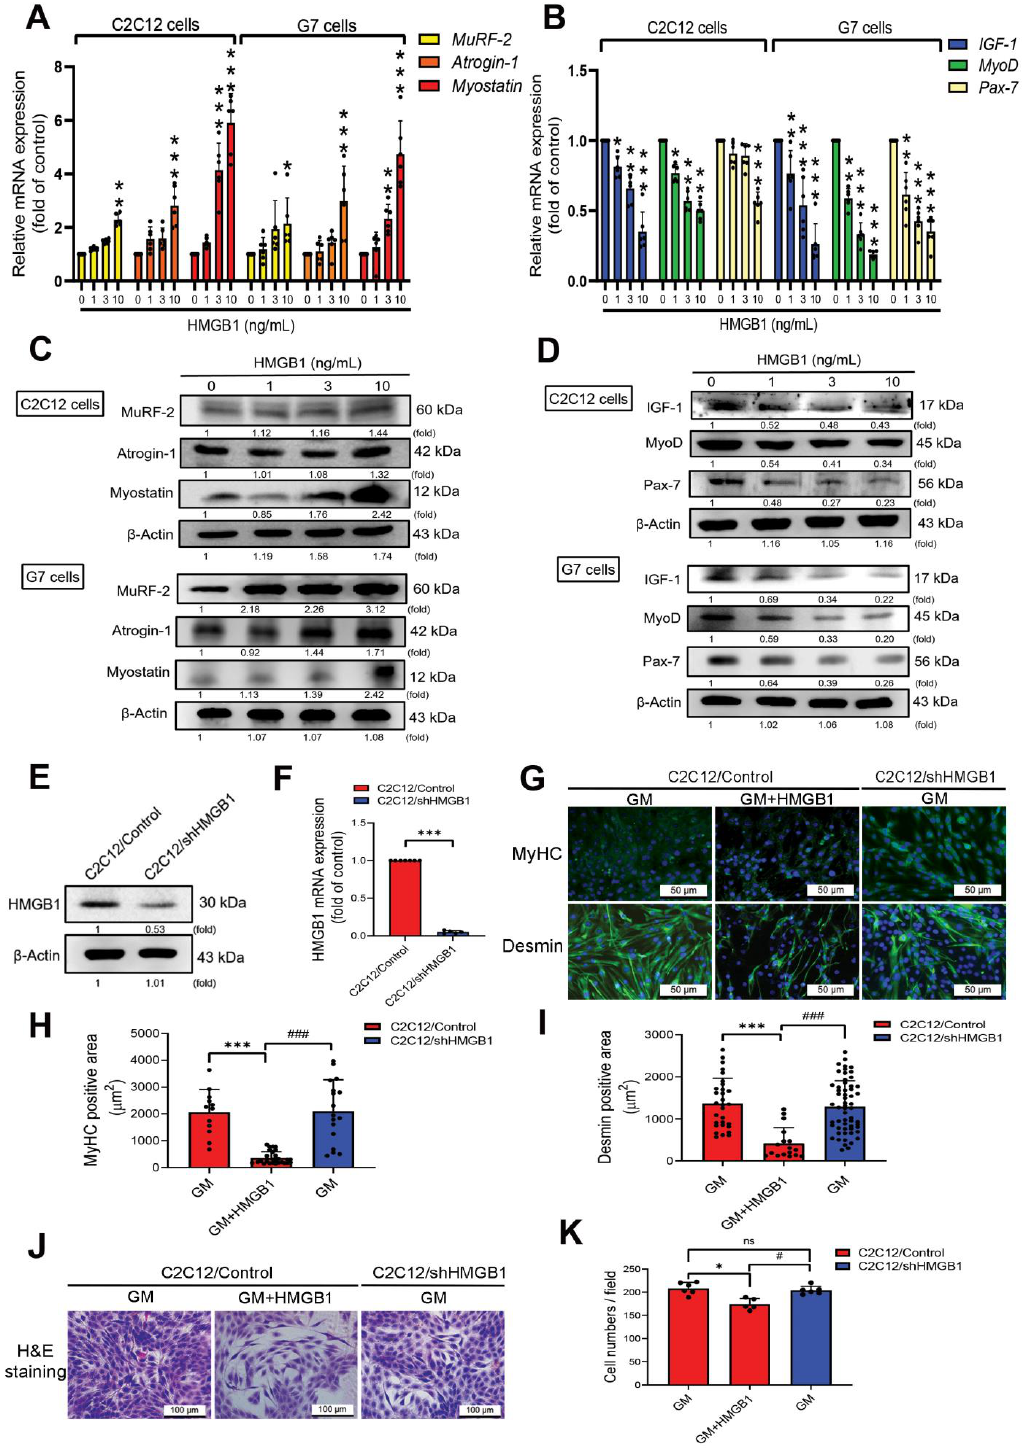
Figure 1. HMGB1 attenuates myogenic marker expression and muscle differentiation in myoblasts. ( A – D ) Levels of mRNA and protein expression of muscle atrophy and myogenic markers in